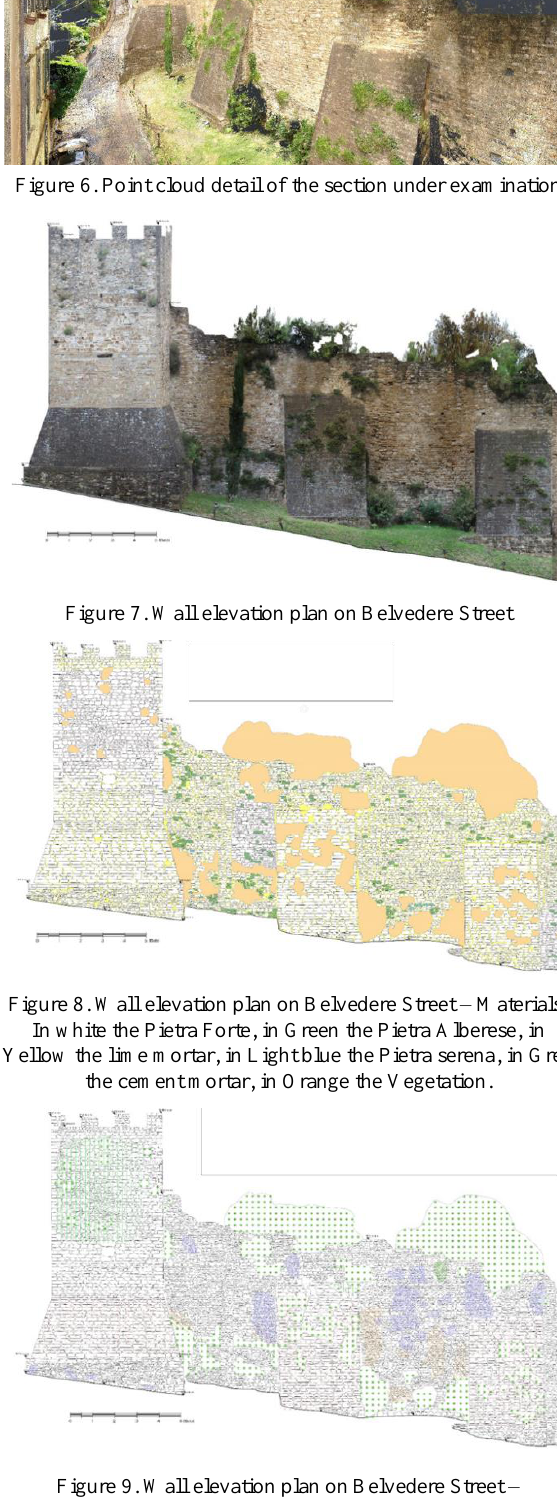
Figure 9. Wall elevation plan on Belvedere Street – Deterioration: The green dots are the vegetation, in Orange the Erosion, in Violet the exfoliation, the Green lines are the organic